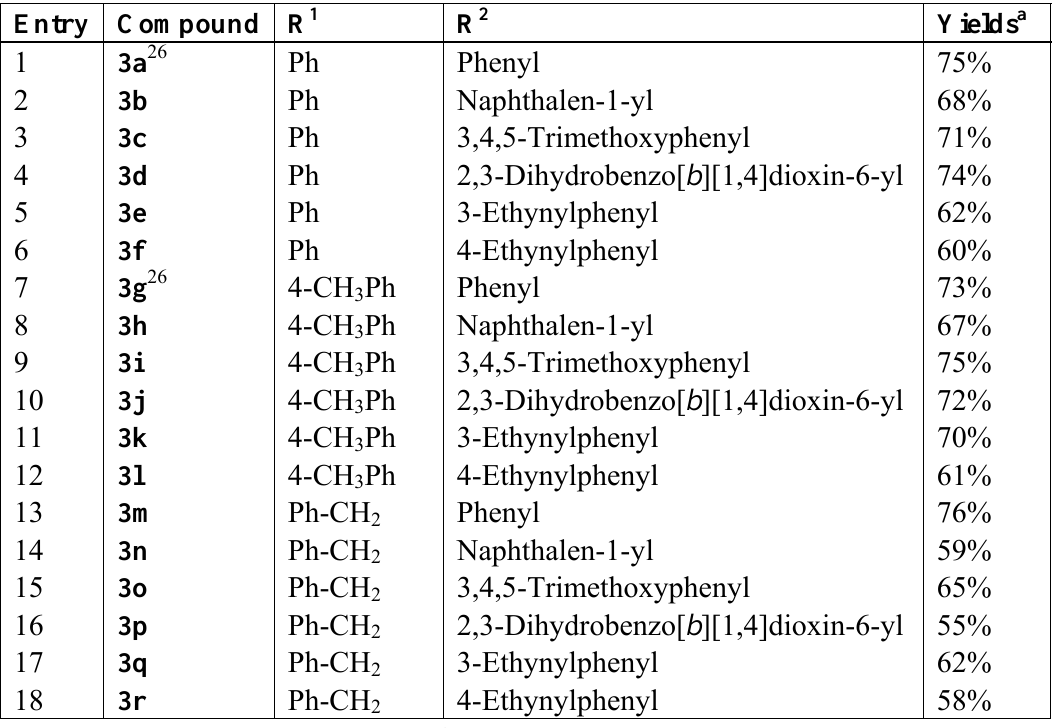
Table 1. Synthesis of 6-amino-5-cyano-1,4-disubstituted-2(1 H )-pyrimidinones 3a-r